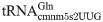
Gene organization of plasmids pUST313 and pUST314.Plasmid pUST313 harbors the genes glnU and glnW (red) encoding the (c)mnm5s2U34 containing Gln-tRNA (tRNAcmnm5s2UUGGln) and genes glnV and glnX (blue) encoding the C34 containing tRNACUGGln. Plasmid pUST314 is a spontaneous plasmid mutant in which a recombination has occurred between metT (tRNAac4CAUMet) and metU (also tRNAac4CAUMet) (green) resulting in a deletion of the glnU and glnW genes encoding tRNAcmnm5s2UUGGln and leuW (black). Note, only part of the asnB and STMO672 genes are present (shaded gray) suggesting that these defective genes do not express any full sized protein. Plasmid p815 (not shown in the figure but used in some experiments) contains the valU operon, which consists of genes valU, valX, valY and lysV. The latter is the structural gene for tRNAmnm5s2UUULys.